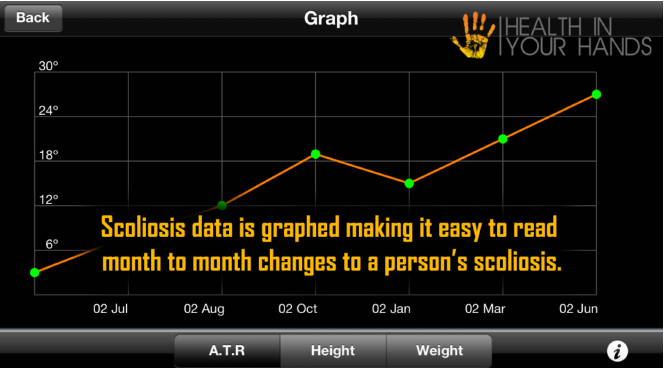
Figure 3. ScolioTrack. (This figure is a snapshot taken by the screen of the app).